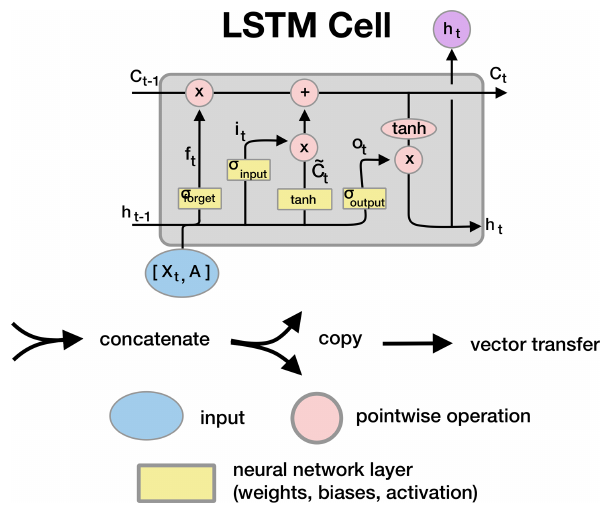
Figure F1. Wiring diagram for the LSTM recurrent cells, adapted from Olah (2016) and reproduced with permission from Lees et al. (2021). These cells are repeated for each input timestep in our se- quence length. In the LSTM, the cell state C t passes from timestep to timestep, capturing the state of the system at time t . The informa- tion flow from the input data to C t is controlled by a series of gates, the forget gate ( f t ), the input gate ( i t ), and the output gate ( o t ). ˜ C t represents the candidate cell-state values, values transformed through the tanh layer that are passed into C t dependent on the output of the input gate. Note that the neural network layers cor- respond to the weights ( W ), biases ( b ), and activation functions ( σ , tanh). These operations correspond to the yellow layers in the dia-